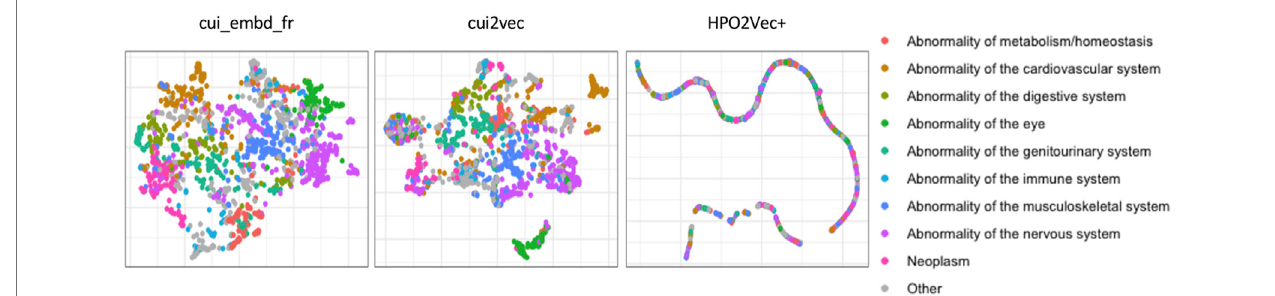
FIGURE 2 | Phenotype projection of different medical concept embeddings. The phenotypes were colored according to their hierarchical categories in HPO.